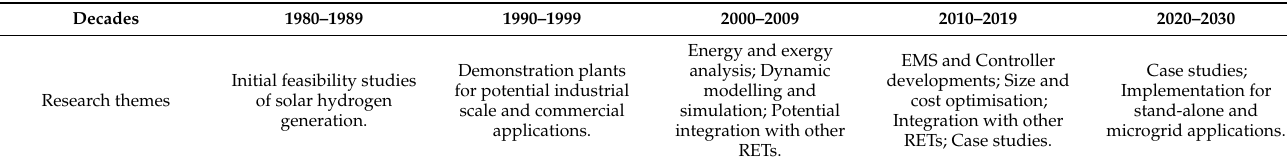
Table 2. Timelines and themes that dominated the development of IPVFC